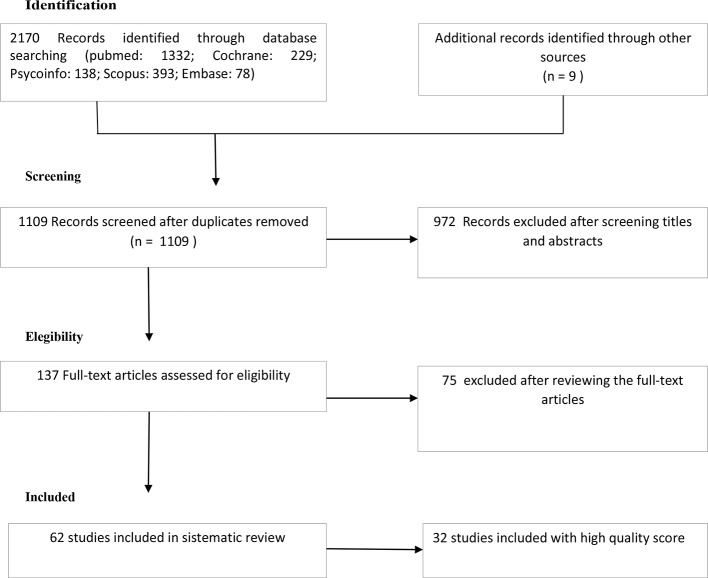
Flow diagram of inclusion procedure.